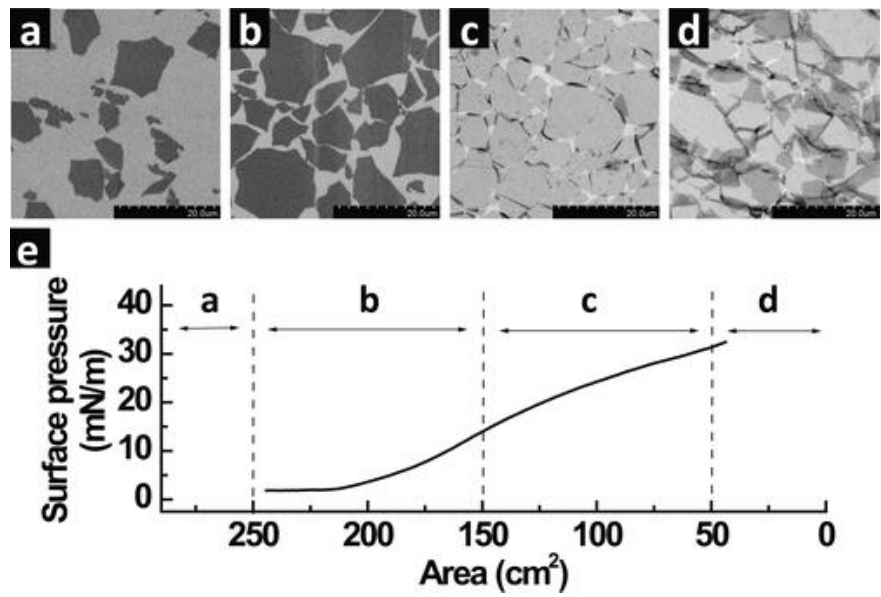
Figure 2. The LB assembly of single monolayers of GO on top of a silicon wafer with different regions of compression area: ( a ) dilute monolayers of isolated GO sheets, ( b ) close-packed arrangement, ( c ) over-packed monolayers with a folded sheet at interconnecting edges and ( d ) over-packed monolayers with folded and partially overlapped GO sheets interlocking with each other. ( e ) Isothermal surface pressure versus subphase (water) area plotted for the corresponding regions of ( a – d ). Scale bar is 20 µm. Reprinted with permission from the Journal of the American Chemical Society, copyright 2009, American Chemical Society [37].